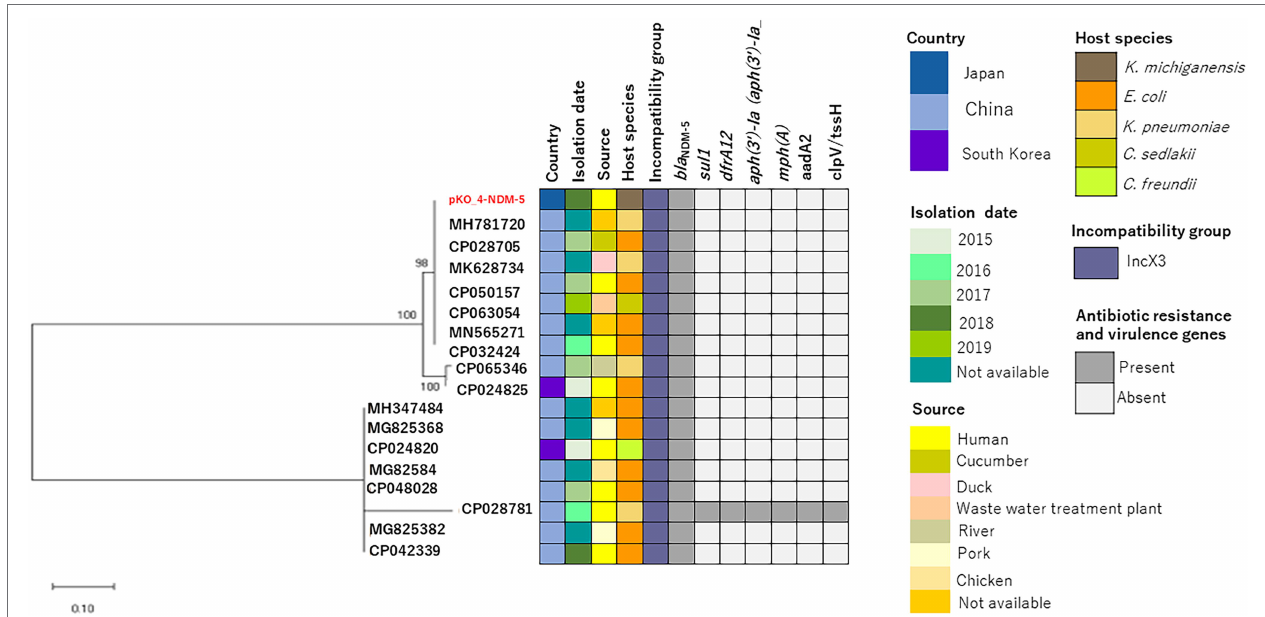
FIGURE 2 | Evolutionary relatedness of pKO_4-NDM-5 and other IncX3- bla NDM-5 -containing plasmids. The maximum-likelihood phylogenetic tree of these IncX3- bla NDM-5 plasmids was constructed using MEGA X software, and their bootstrap values are shown next to the branches. The plasmid metadata are also